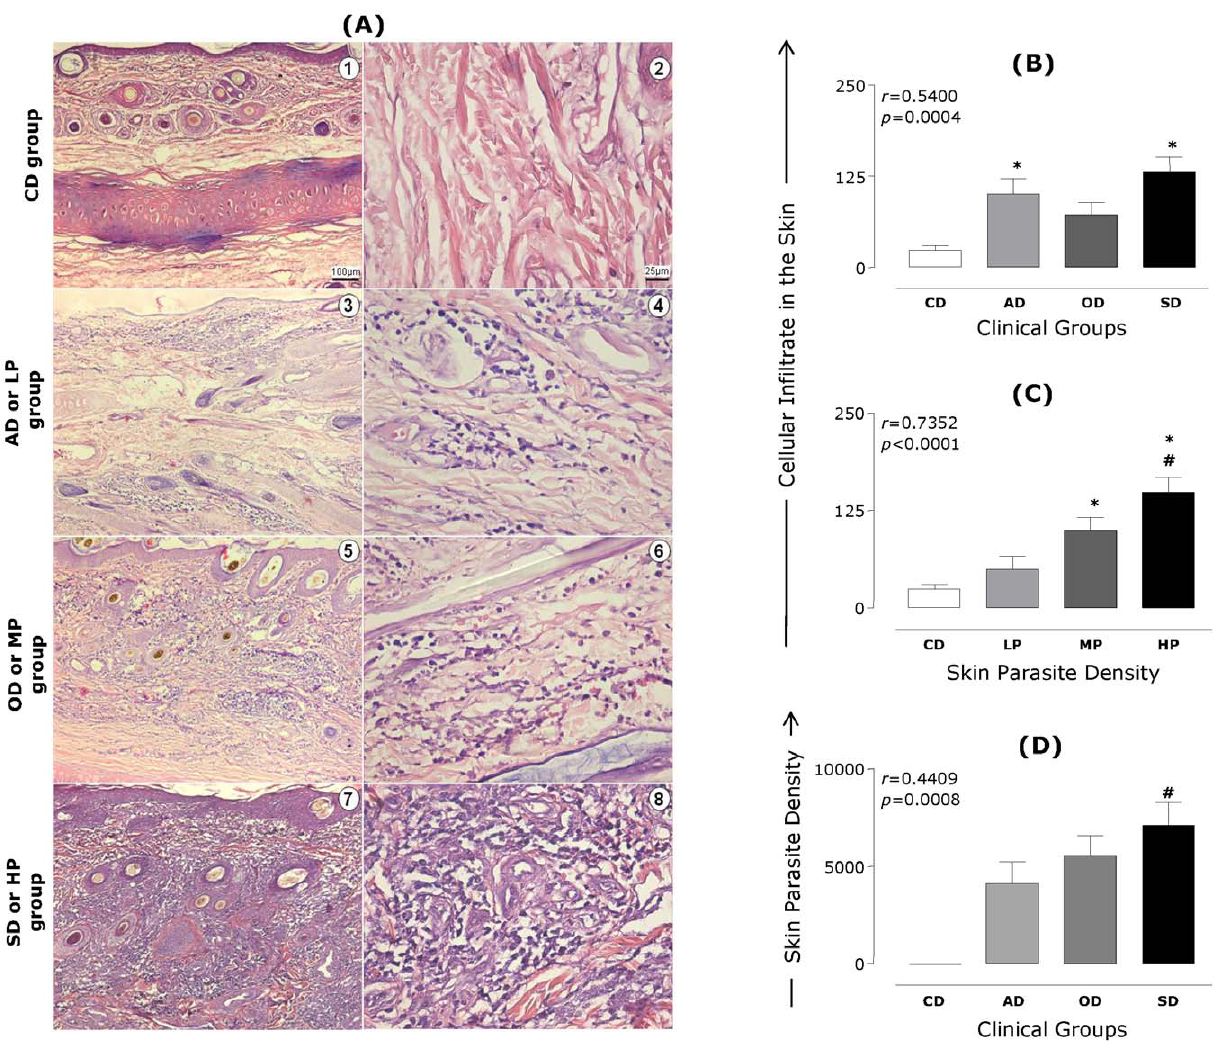
Figure 1. Histopathological and parasite density analyses of skin of dogs naturally infected with L.infantum . Animals were categorized according to their clinical status into asymptomatic (AD, n =10), oligosymptomatic (OD, n =10), or symptomatic (SD, n =15) or categorized according to skin parasite density into low (LP, n =12), medium (MP, n =11), or high (HP, n =12) parasite density. The control group is represented by CD ( n =16). Photomicrographs of cutaneous cellular infiltrates from dogs naturally inflected by L. infantum stained by hematoxylin and eosin ( A ). Representative cellular infiltrates of study groups are depicted: Control dogs (1 and 2 ); AD or LP (3 and 4); OD or MP (5 and 6); SD or HP (7 and 8). Left panels: Slides shown at 10 6 magnification; bar, 100 m m. Right panels: Slides shown at 40 6 magnification; bar, 25 m m. Correlation between quantitative analysis of cutaneous cellular infiltrate with clinical status ( B ) or skin parasite density ( C ) are presented. Correlation between clinical groups and skin parasite density is also presented ( D ). The results are expressed as the mean number of cells present in cutaneous cellular infiltrates evaluated at 20 fields plus standard deviation. In ( D ), the results are expressed as the mean of the log number of skin parasite density plus standard deviation. Significant differences ( p , 0.05) compared with CD and AD or LP groups are indicated by symbols * and # , respectively. Spearman’s correlation indexes ( r and p values) are shown on the graphs when applicable.